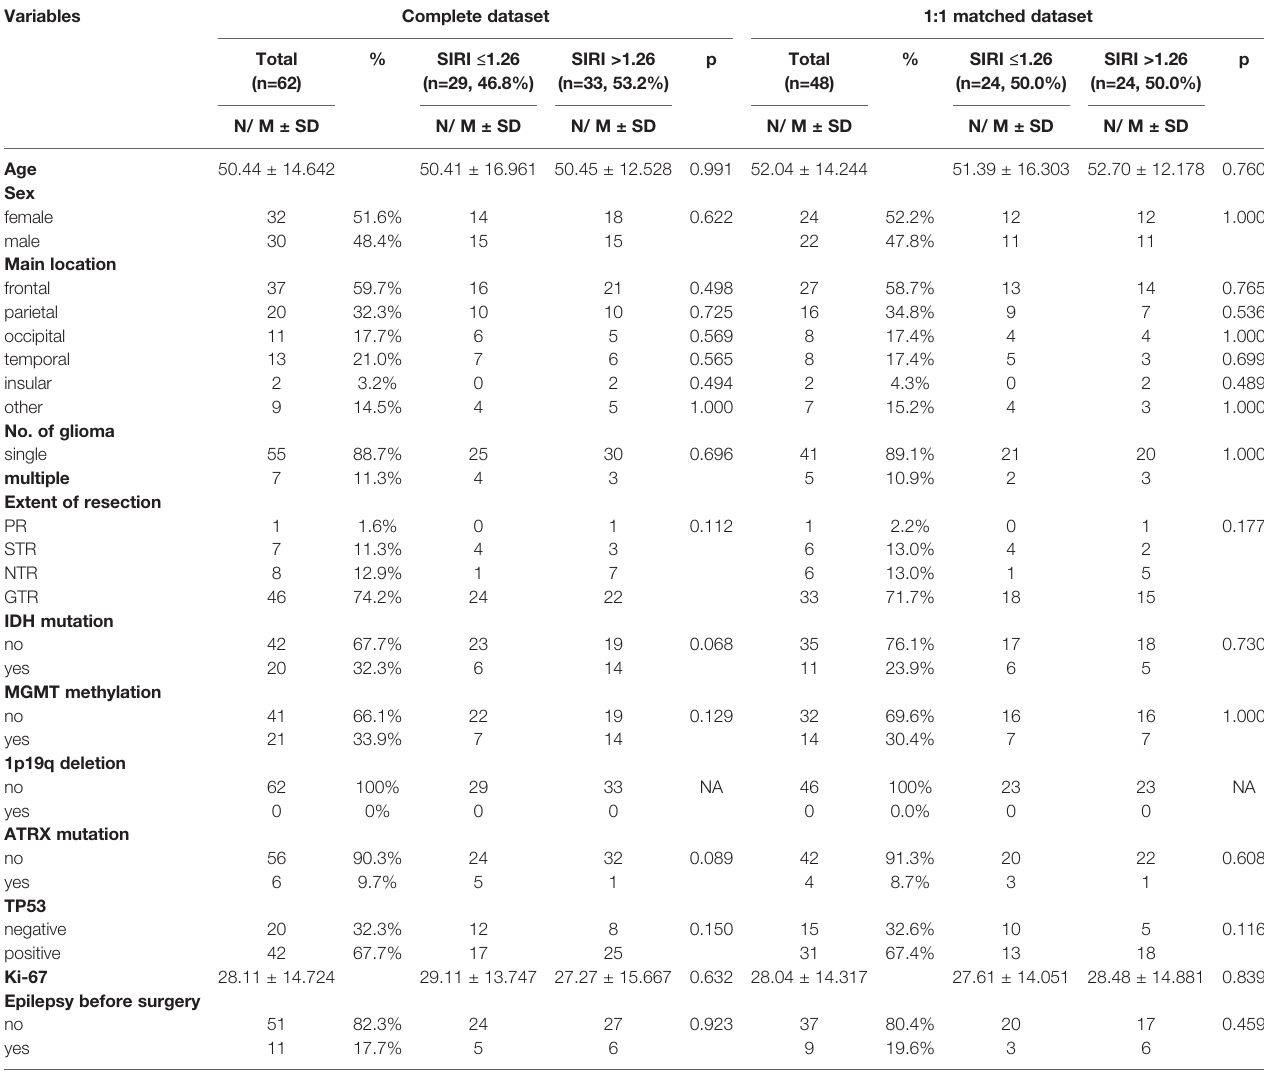
TABLE 1 | Baseline patient characteristics strati fi ed by in fl ammatory marker levels in grade IV glioma. Variables Complete